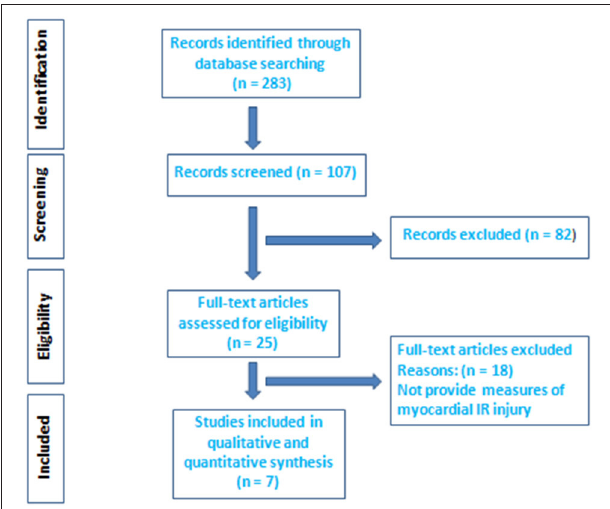
FIGURE 1 | Election of the studies on the basis of the Preferred Reporting Items for Systematic Reviews and meta-analysis flow diagram. IR, ischemia/reperfusion.